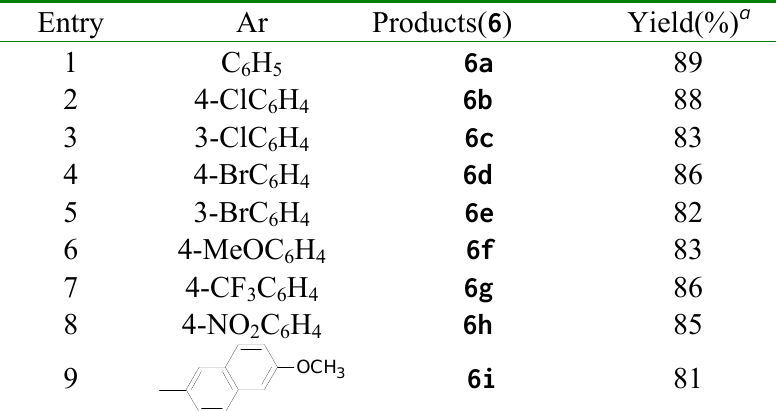
Table 2. Synthesis of 1 H